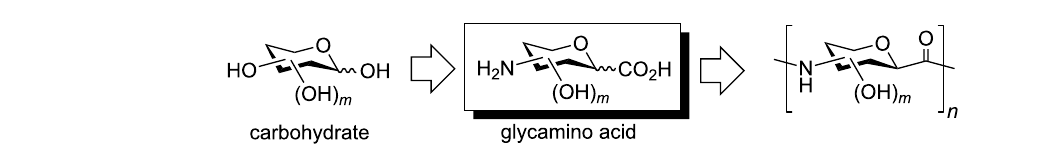
Figure 3: The general structure of glycoamino acids and their corresponding oligomers.